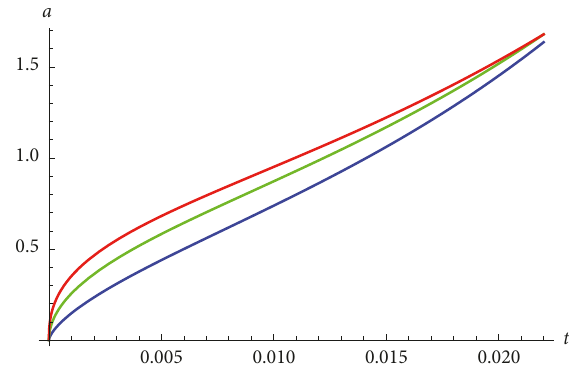
Figure 4: The diagram of the evolution of the scale factor with respect to the cosmological time 𝑡 , which is described by (46). For illustration, two example values of the parameter 𝛼 21 = are chosen: −1 and −2 . The bottom blue curve describes the evolution of the scale factor in the Λ CDM model. The middle curve describes one for 𝛼 21 = −1 and the top red curve describes one for 𝛼 21 = −2 . The cosmological time 𝑡 is expressed in s Mpc / km.